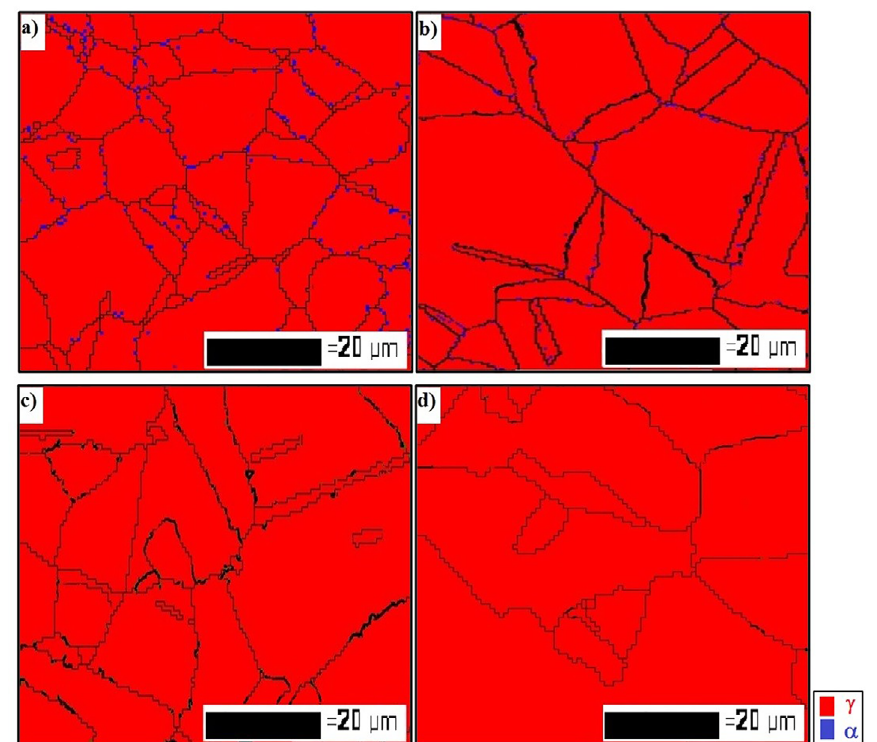
Figure 7. EBSD maps of hot rolled samples with 80% reduction and then solubilized. Increase by 500×. a) 20% manganese, b) 22% manganese, c) 26% manganese and d) 28% manganese. Source: